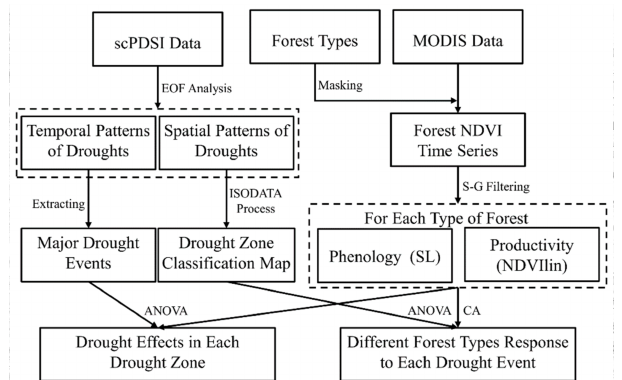
Figure 2. Flow diagram of the determination of spatial-temporal patterns of droughts in the period 2000–2015. SL and NDVIlin are the abbreviations of growing season length and NDVI large integral (a forest productivity proxy), respectively. Dashed rectangles indicate the major outputs from major data processing